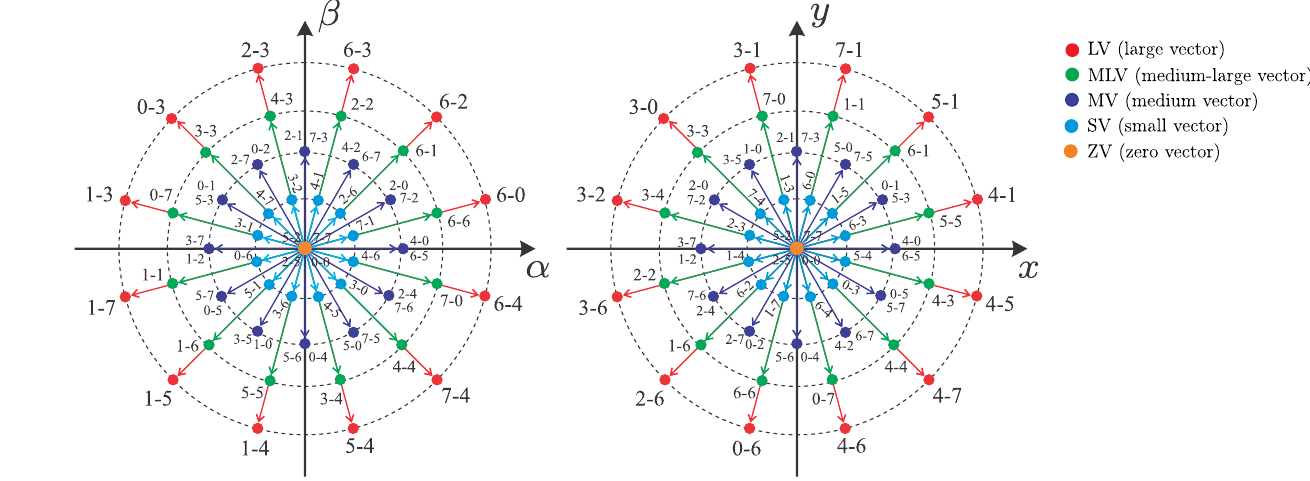
Figure 2. Voltage vectors in the α – β and x – y planes for a six-phase IM